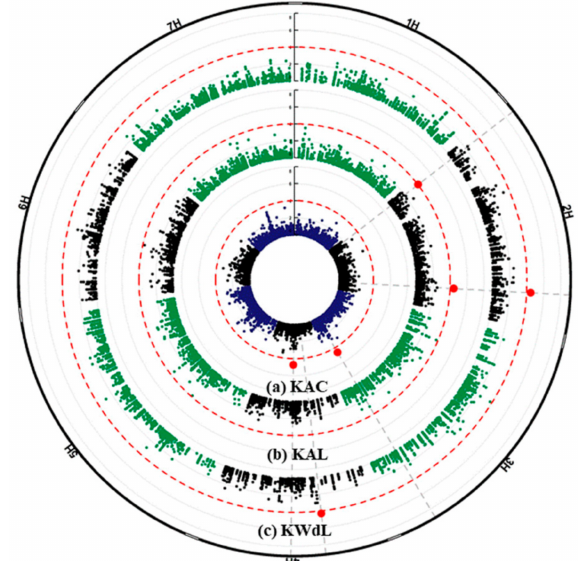
Figure 7. Circular Manhattan plots of genome-wide association scans for central (blue) and lateral (green) spikelets for ( a ) and ( b ) kernel area (KA), and ( c ) kernel width (KWd). The significance level of marker-trait associations ( − log p values) is represented by the vertical scale bar. Individual chromosomes are represented on the outer circle and separated from each other by white borders. − log p values ( p < 10 − 4 ) are indicated by dashed circles. Genomic regions of detected QTL on the respective chromosomes are colored in red (outer